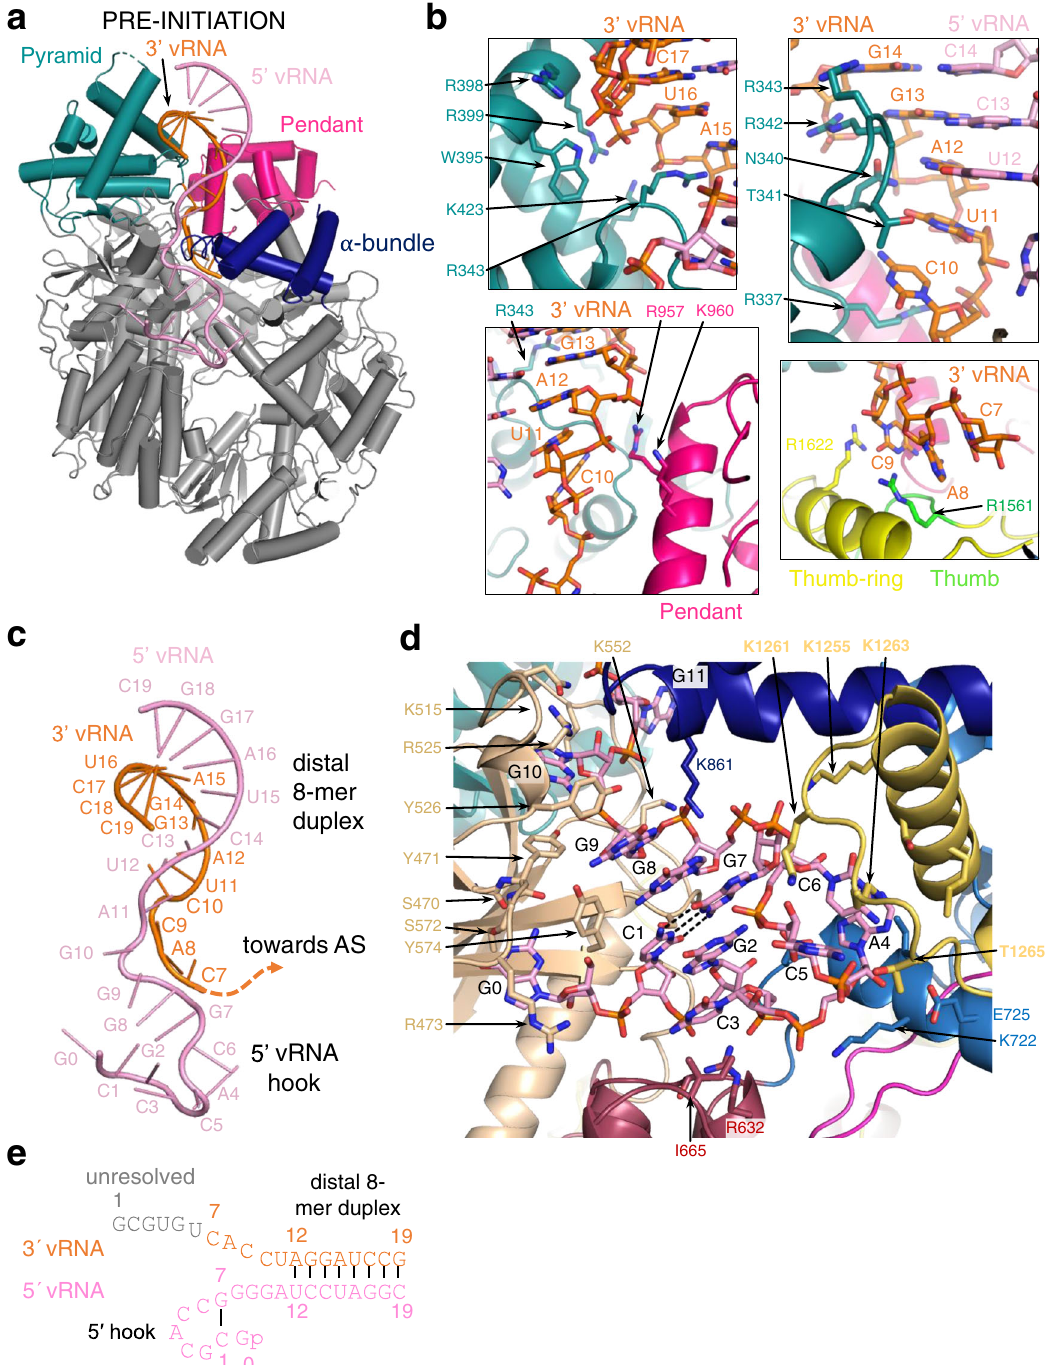
Fig. 2 L protein in the pre-initiation state. a Ribbon diagram of the PRE-INITIATION structure with pendant domain (pink), α -bundle (dark blue), pyramid (teal), 3 ′ vRNA nts 7 – 19 (orange) and 5 ′ vRNA nts 0 – 19 (pink) highlighted in colour and indicated by name. b Interactions of the L protein pyramid (teal), pendant (pink) thumb-ring (yellow) and thumb (green) domains with the 3 ′ vRNA are shown. Important amino acid side chains and the RNA nucleotides of 3 ′ and 5 ′ vRNA are shown as sticks with respective labels. c Viral RNA observed in this structure with a 5 ′ vRNA hook structure composed of 5 ′ vRNA nts 0 – 9 and a distal duplex region involving 5 ′ vRNA nts 12 – 19 and 3 ′ vRNA nts 12 – 19. The 3 ′ vRNA nts 1 – 11 are directed towards the RdRp active site (towards AS) but not resolved. d Close-up of the 5 ′ RNA hook binding site involving the fi ngers domain (blue), fi nger node (light yellow), pyramid base (wheat) and helical region (raspberry). Residues important for the RNA-protein interface and nucleotides are shown as sticks and are labelled. e Schematic presentation of the promoter RNA (3 ′ vRNA in orange, 5 ′ vRNA in pink) in the PRE-INITIATION structure. Nucleotides 1 – 6 of the 3 ′ vRNA, which are not resolved, are coloured in grey. Distal duplex and 5 ′ hook regions are